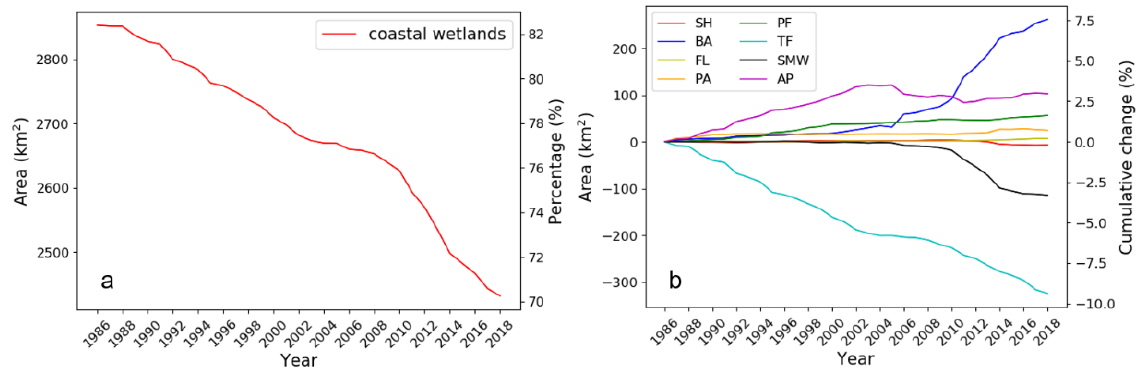
Figure 4. Changes of different land cover types from 1986 to 2018. Coastal wetlands, including seepweed, reed fields, tidal flats, and shallow marine water ( a ). Area of individual land cover types ( b ) SH: seepweed; BA: built-up area; FL: forest land;